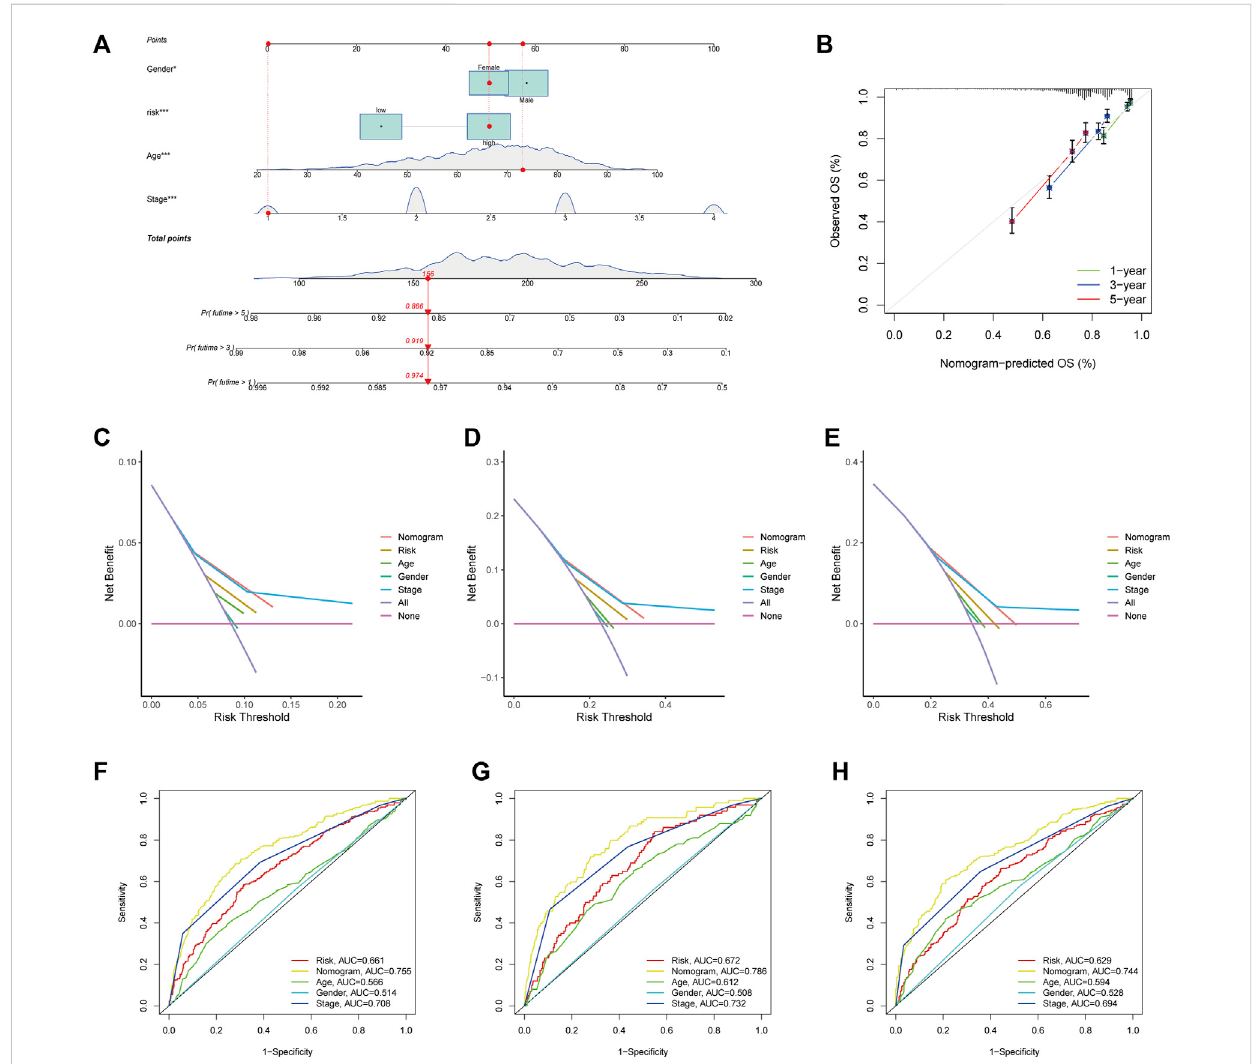
FIGURE 8 Developmentandvalidationofthenomogram. (A) Nomogramforpredicting1-,3-,and5-yearOSintheentirecohortofcolorectalcancerpatients. (B) The Calibration curve of the nomogram. (C – E) The DCA curves of the nomograms compared for 1-, 3-, and 5-year OS in CRC, respectively. (F – H) ROC curves comparing 1, 3, and 5 years in patients with colorectal